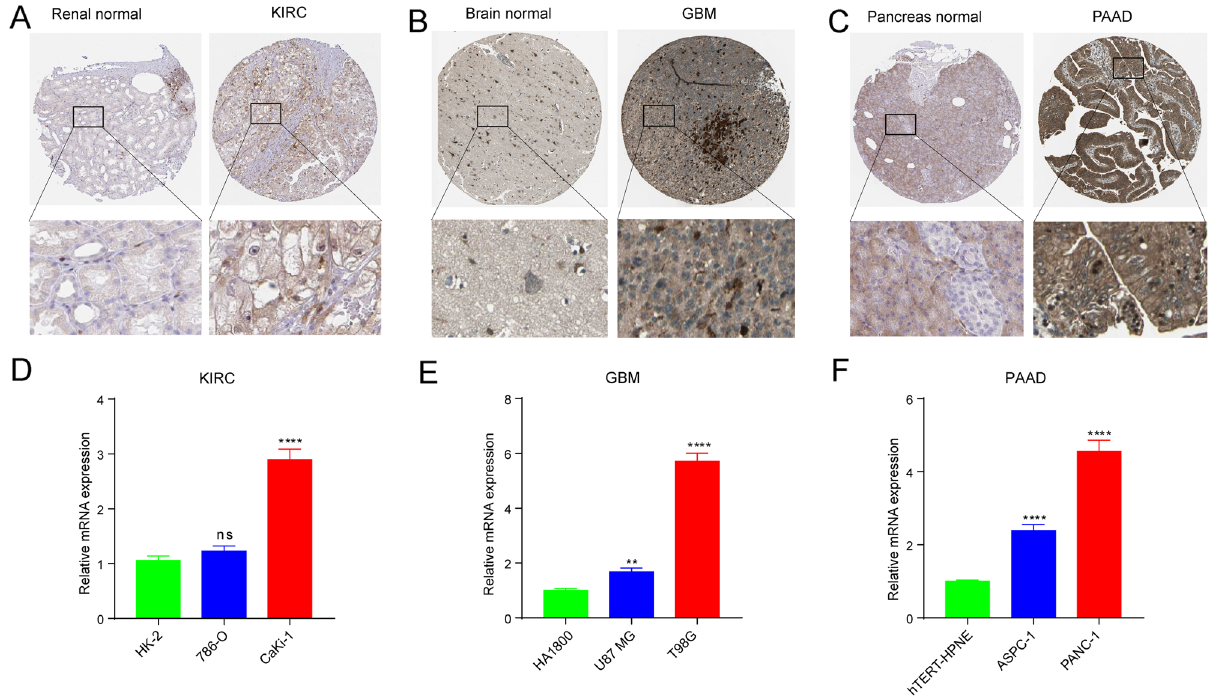
Figure 3. Protein and mRNA expression levels of PYCARD. ( A – C ) The protein expression of PYCARD in ( A ) kidney renal clear cell carcinoma (KIRC); ( B ) glioblastoma (GBM); ( C ) pancreatic adenocarcinoma (PAAD). ( D – F ) The mRNA expression of PYCARD in ( D ) KIRC cells; ( E ) GBM cells; ( F ) PAAD